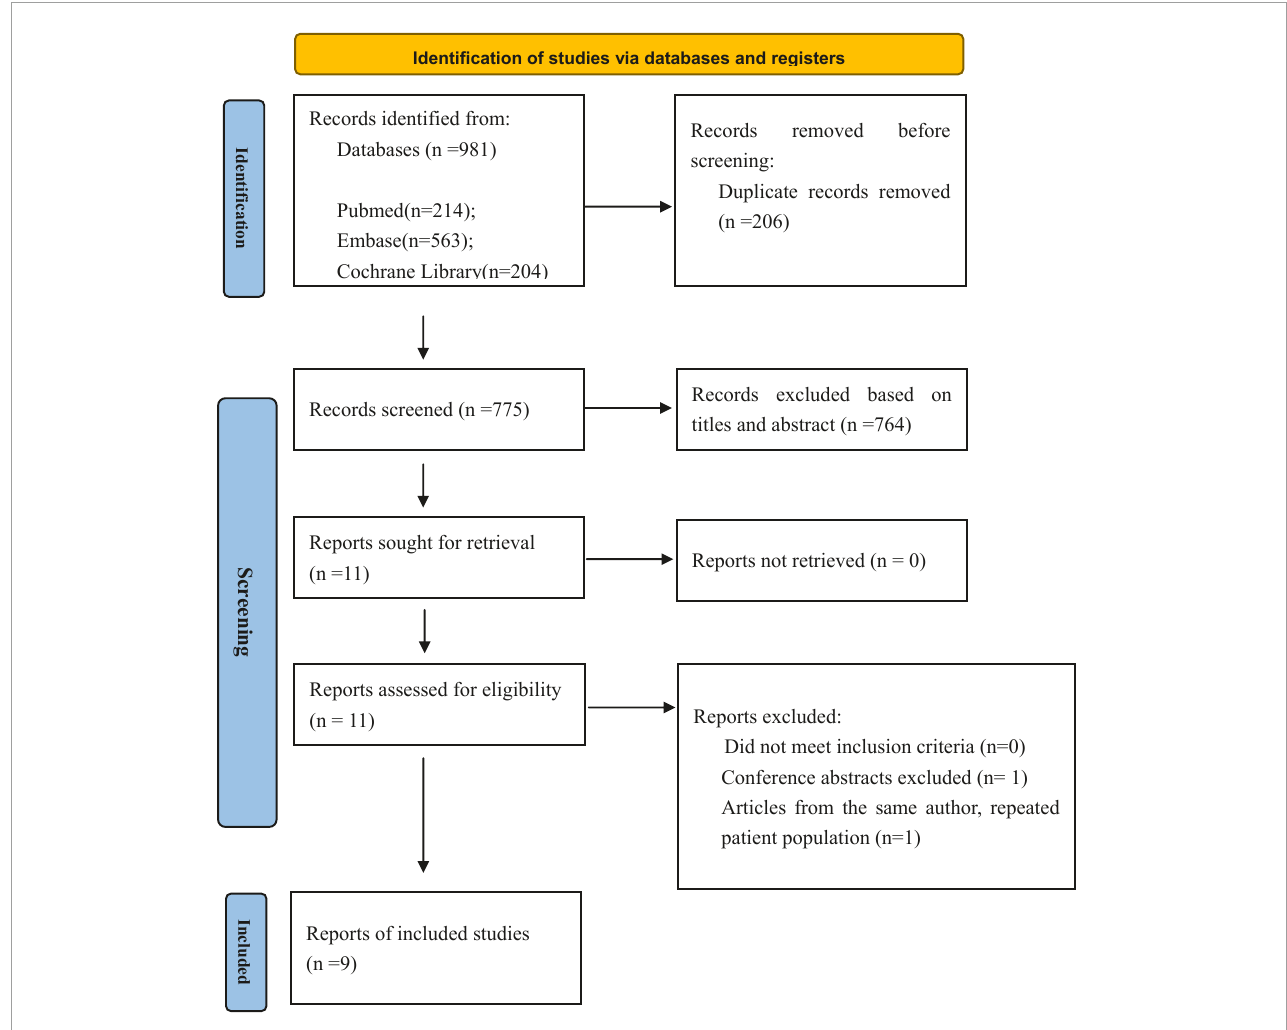
FIGURE1 PRISMA flowchart showing the selection of studies for